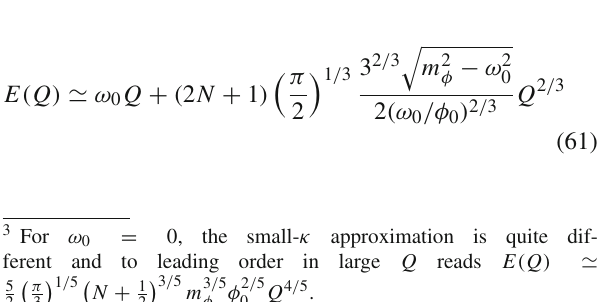
0, 3 we find an expression for E ( Q ) that is valid for large Q